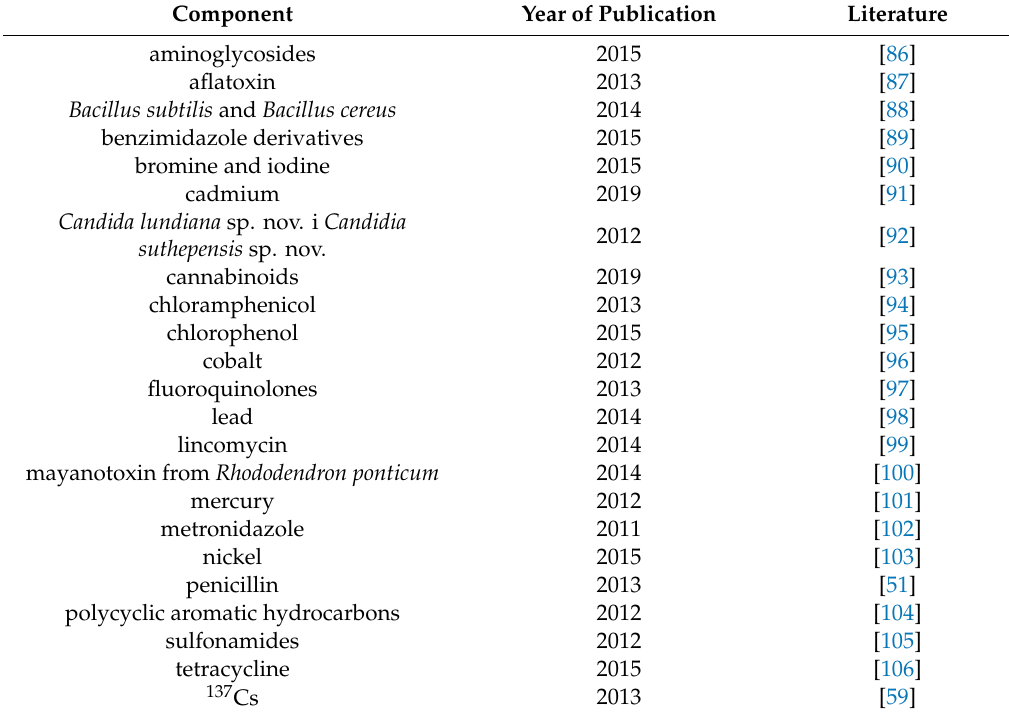
Table 5. Selected contaminants detected in bee honey over the last 10